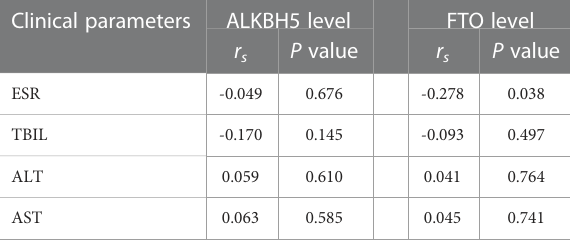
TABLE 4 The correlation between ALKBH5, FTO levels and clinical parameters in PTB patients. Clinical